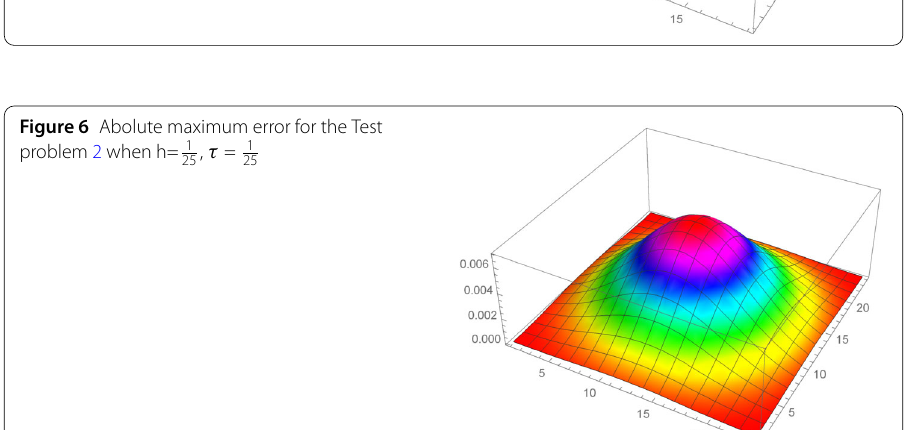
Figure 6 Abolute maximum error for the Test problem 2 when h= 1